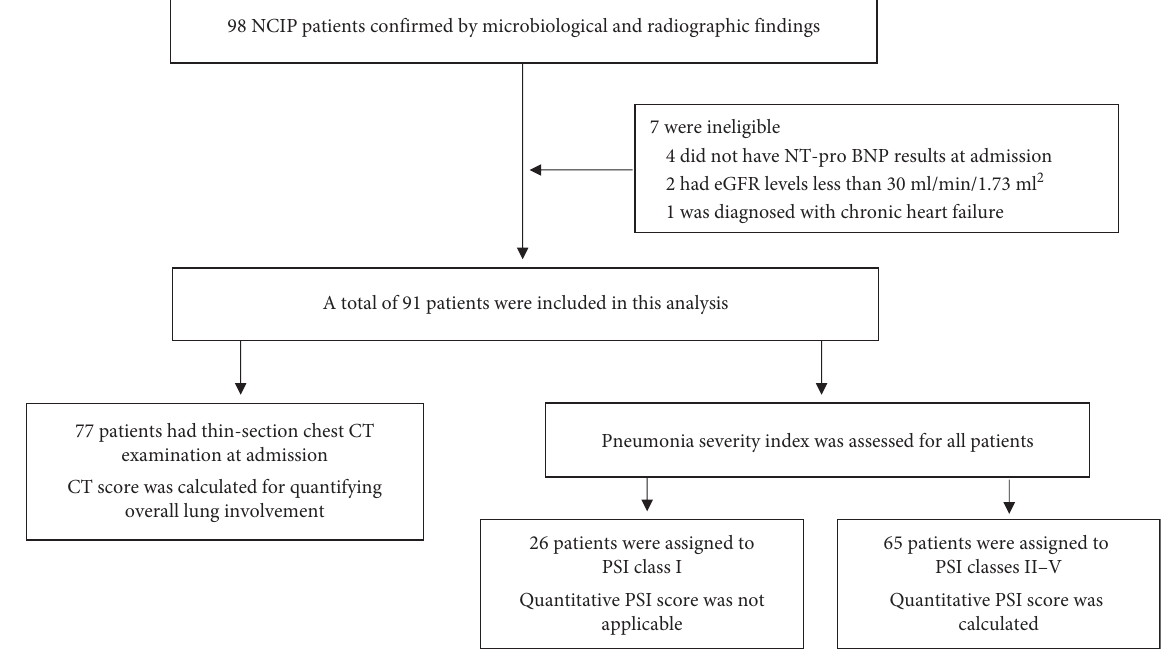
Figure 1: Flowchart of patient inclusion. NT-proBNP: N-terminal pro-B-type natriuretic peptide; eGFR: estimated glomerular filtration rate; HRCT: high-resolution computed tomography; PSI: pneumonia severity